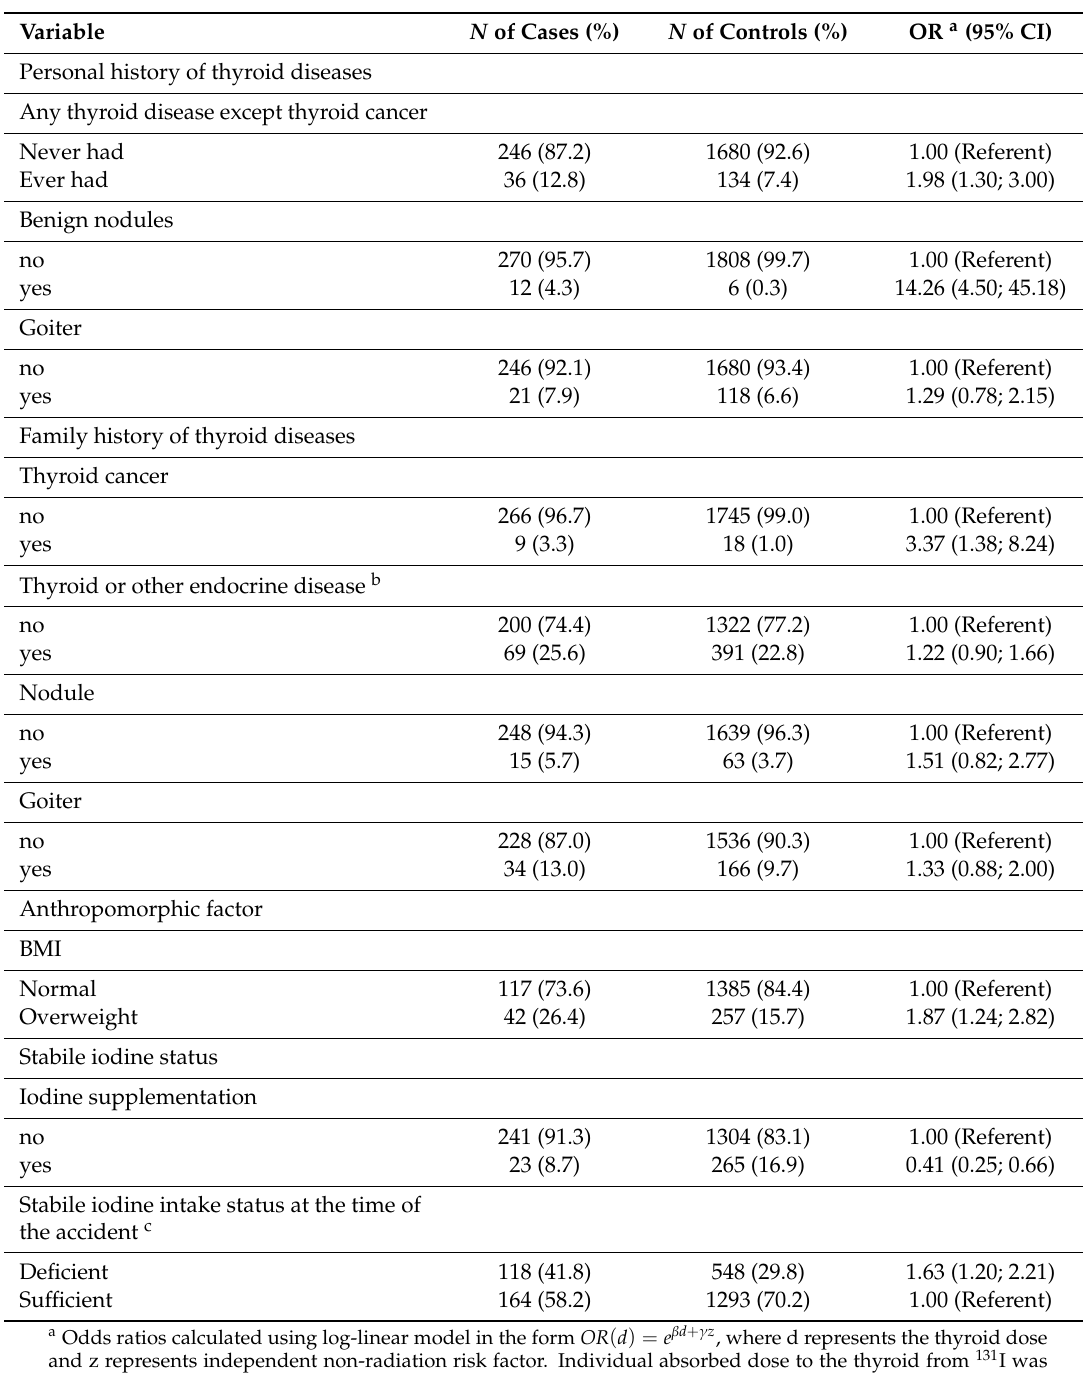
Table 4. Thyroid cancer odds ratios (OR) and 95% confidence intervals (95% CI) for selected risk factors for study subjects with 131 I thyroid doses < 2